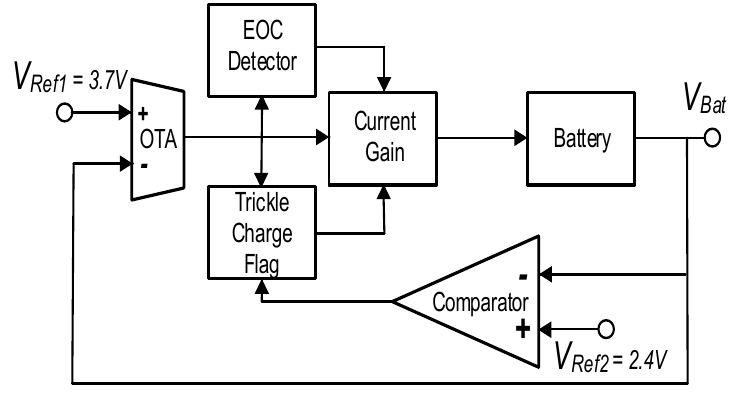
Figure 8. Block schematic of the proposed charger circuit. OTA, operational transconductance amplifier; EOC, end of